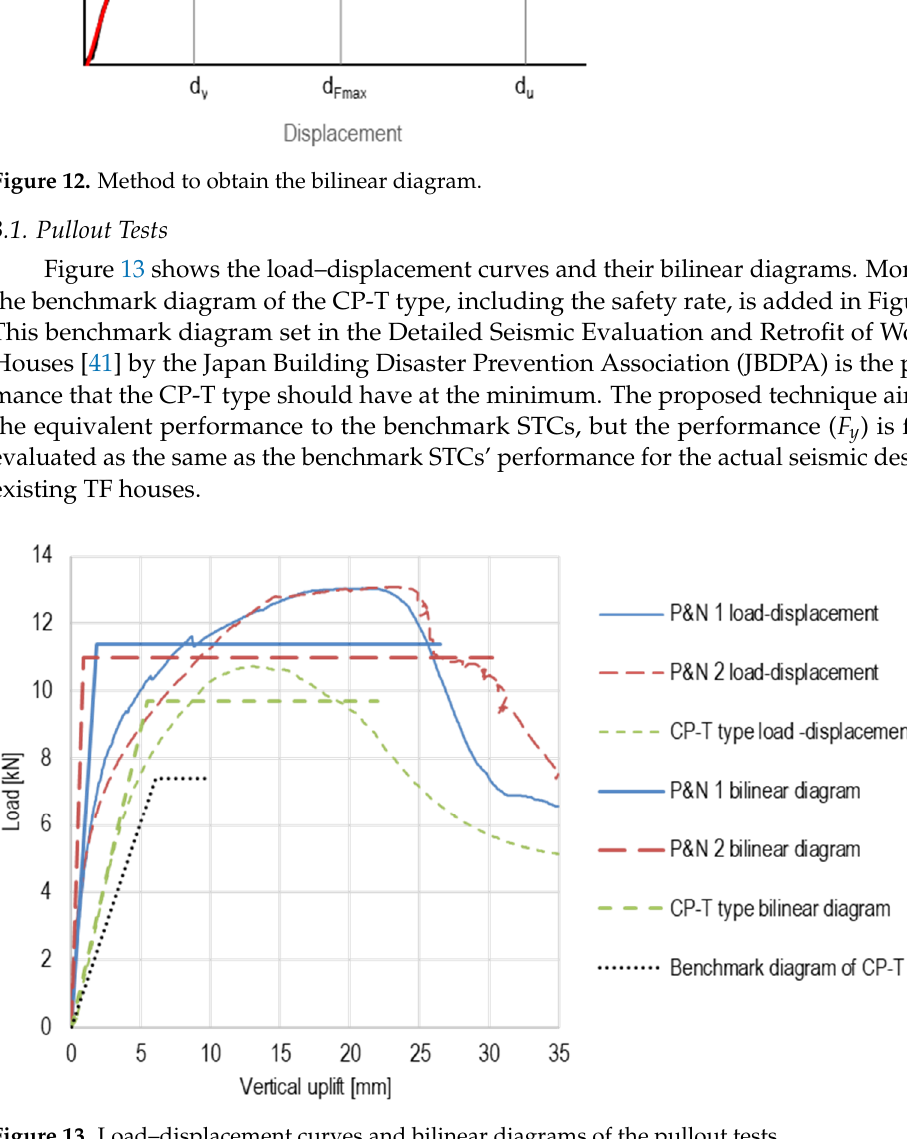
Table 4. Seismic performance parameters from the bilinear diagrams of the pullout